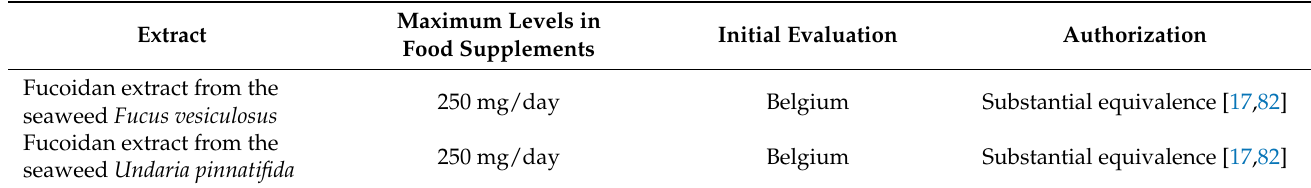
Table 4. Algae extracts authorized as novel foods for its use in food